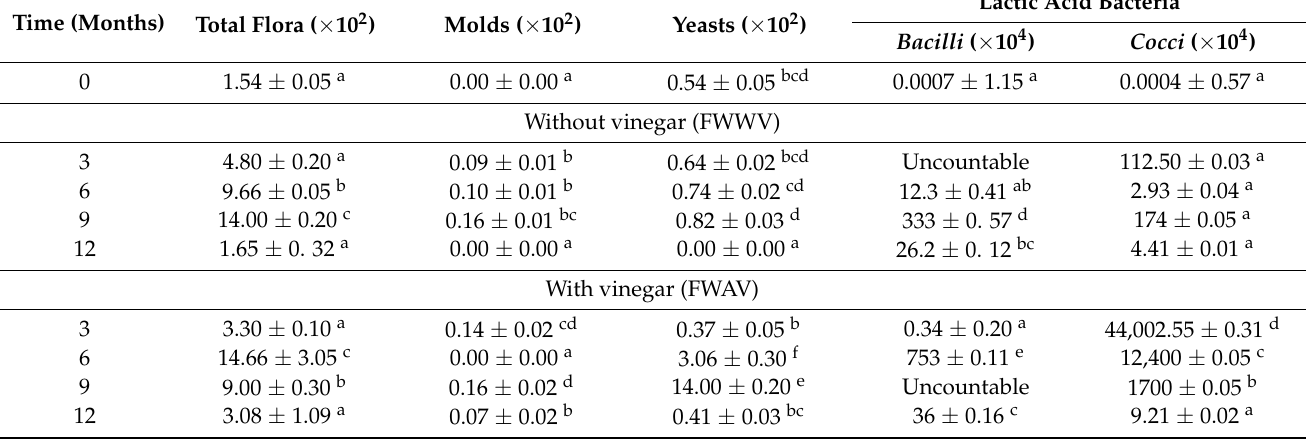
Table 1. Evolution of microbial flora (CFU/g) of durum wheat during fermentation without vinegar and with